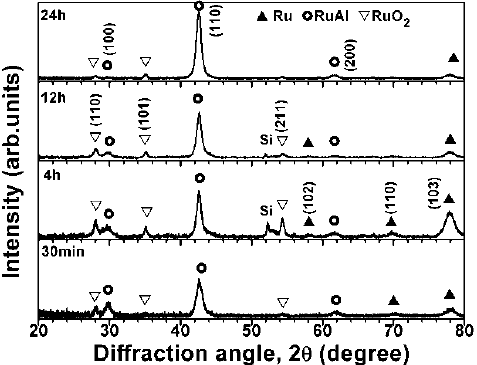
Figure 6. XRD patterns of the Ru 0.48 Al 0.52 thin films annealed in 1% O 2 –99% Ar at 600 ◦ C for 0.5–24 h.